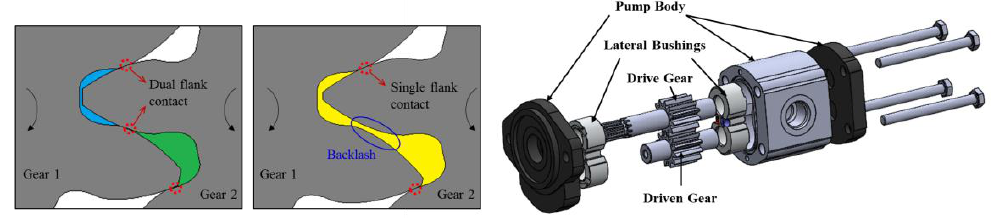
Figure 2. Reference external gear pump.